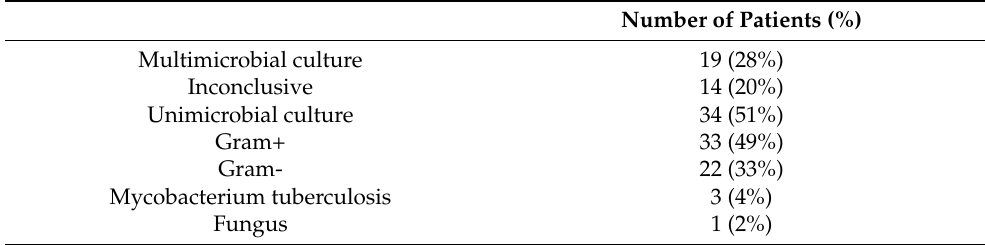
Table 1. Results of 67 microbial cultures in Bezold’s